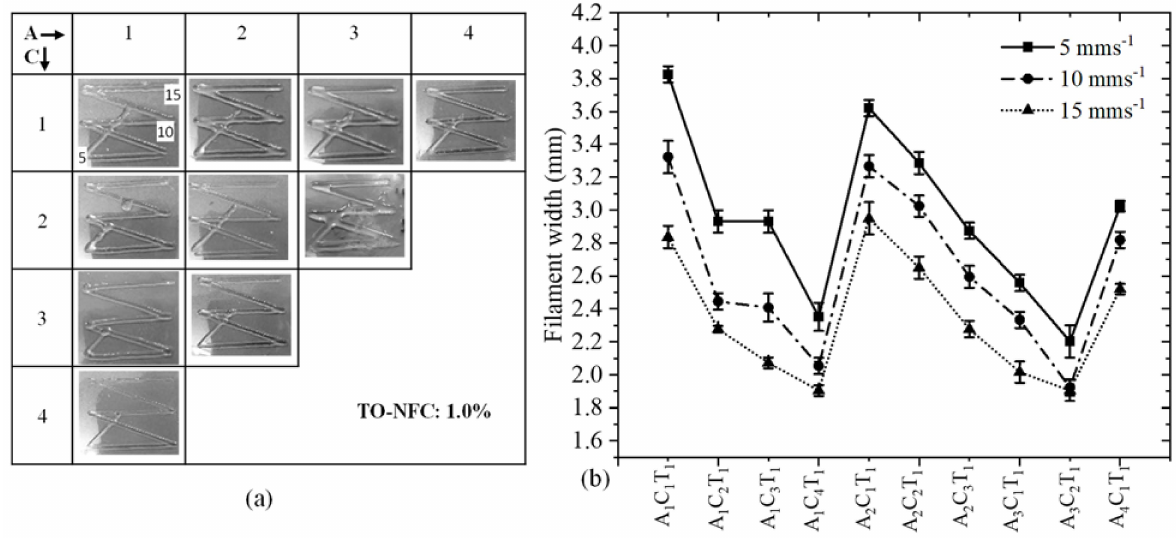
Figure 14. ( a ) Fabricated filaments with 1%, 2%, 3%, and 4% alginate; 1%, 2%, 3%, and 4% CMC; and 1.0% TO-NFC. ( b ) Filament widths of all those